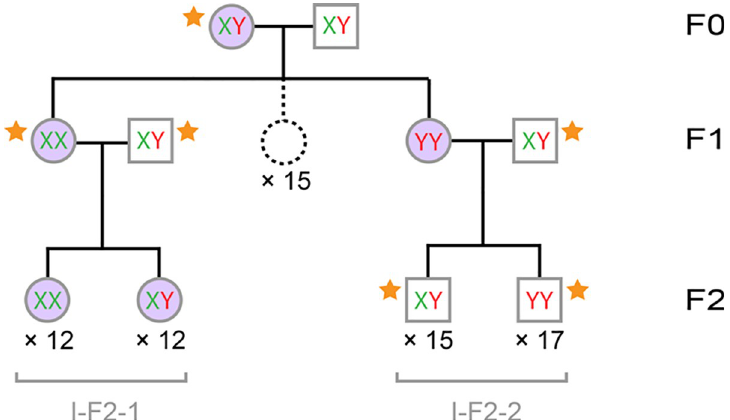
Fig 2. A . nasatum pedigree used to track inheritance of the Y chromosome and Wolbachia . The pedigree spans three generations (F0–F2) and comprises 62 individuals (35 males and 27 females) for which sex chromosome genotype (XX, XY, or YY) was identified and 15 F1 females (not included in the molecular analyses; dotted circle). Males are shown as squares, and females are shown as circles. Individuals carrying Wolbachia are shown in purple. Progeny identifiers are shown in gray. Sex chromosome genotype of individuals marked with an orange star (34 males and two females) was also assessed with a quantitative PCR assay.